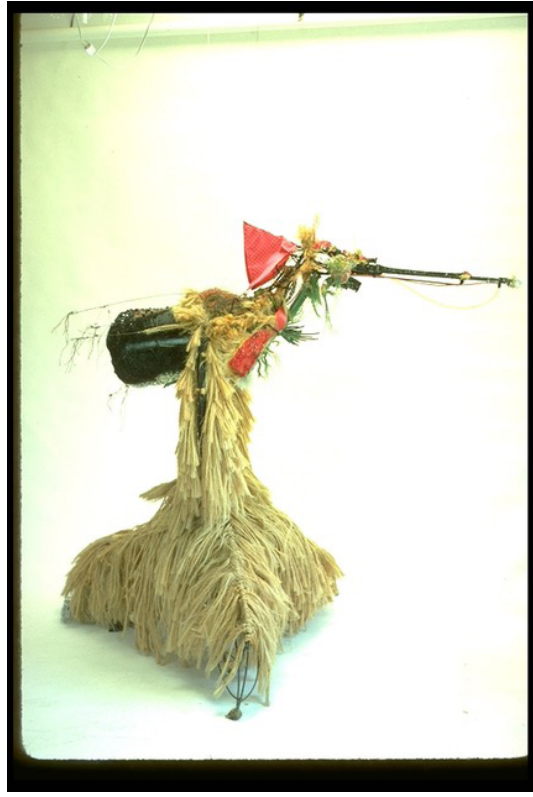
Figure 2. Jim Pallas, The Nose Wazoo , 1990. Image courtesy of